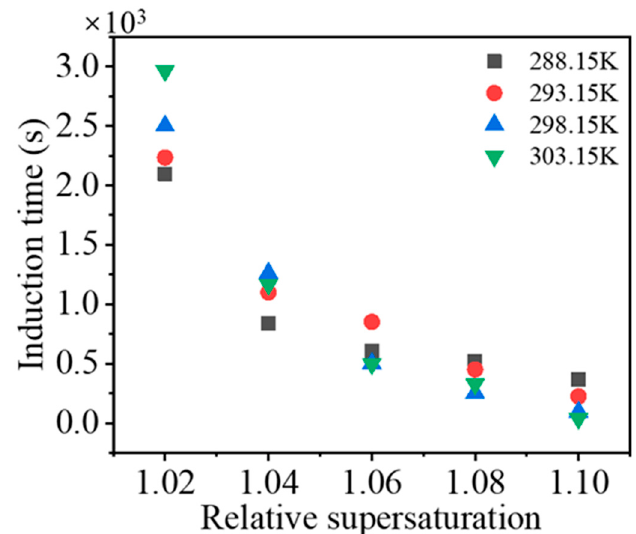
Figure 6. Induction time at different supersaturation levels and temperatures.